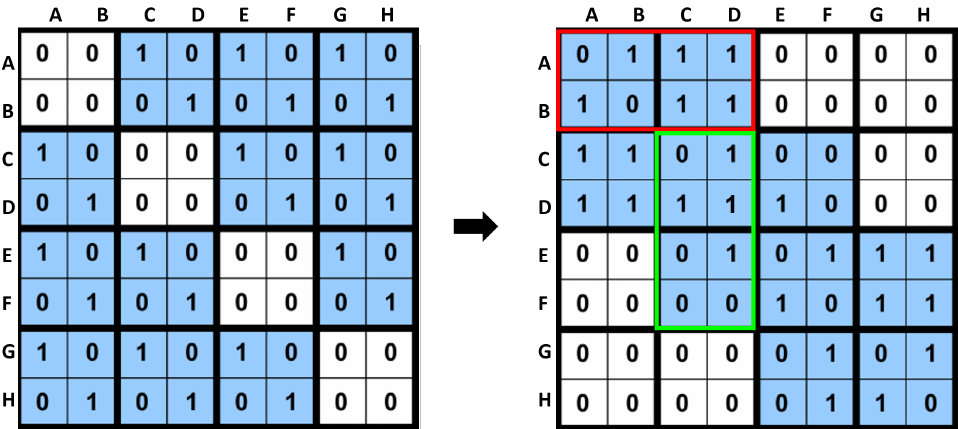
Figure 4. The importance of reordering for HVR. Left : the adjacency matrix is a part of the graph shown in Figure 3: A graph G , and the adjacency matrix M with the random ordering of nodes. Right: adjacency matrix of the same graph, but with a compression-friendly